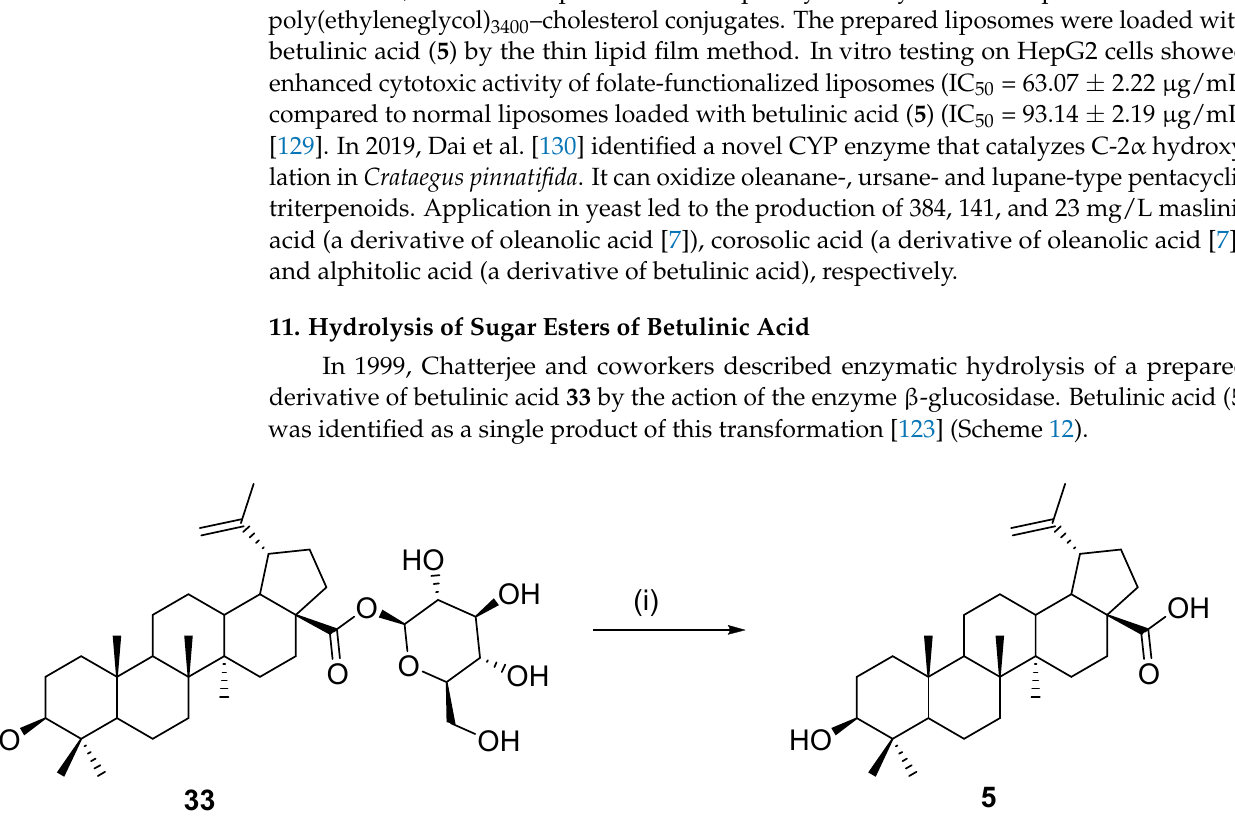
methyl-formamide, and phosphate buffer (pH 5), 37 °C, 72